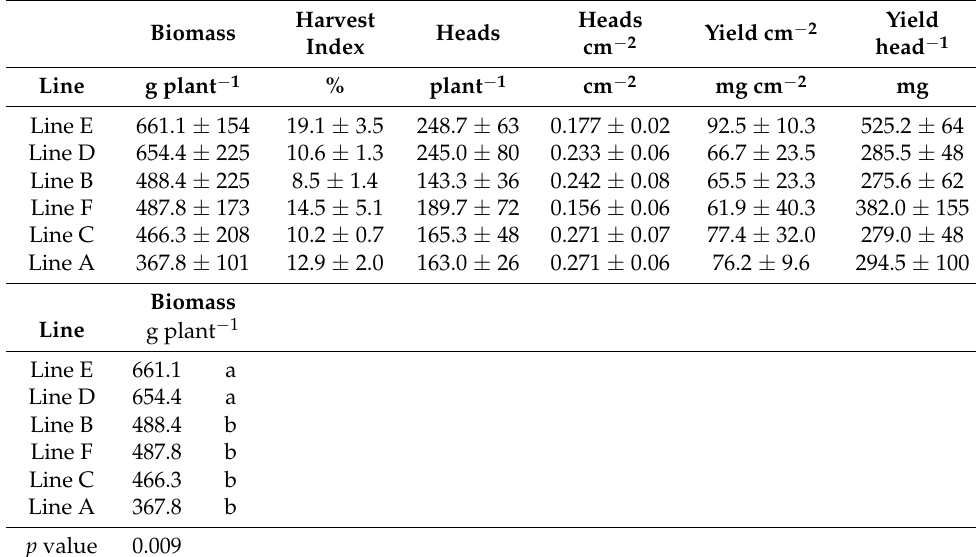
Table 2. Mean biomass plant − 1 , Harvest index, heads plant − 1 , heads cm − 2 , yield cm − 2 of plant areas and yield head − 1 for half-sibling lines of intermediate wheatgrass at Carman, MB harvested over three successive years.